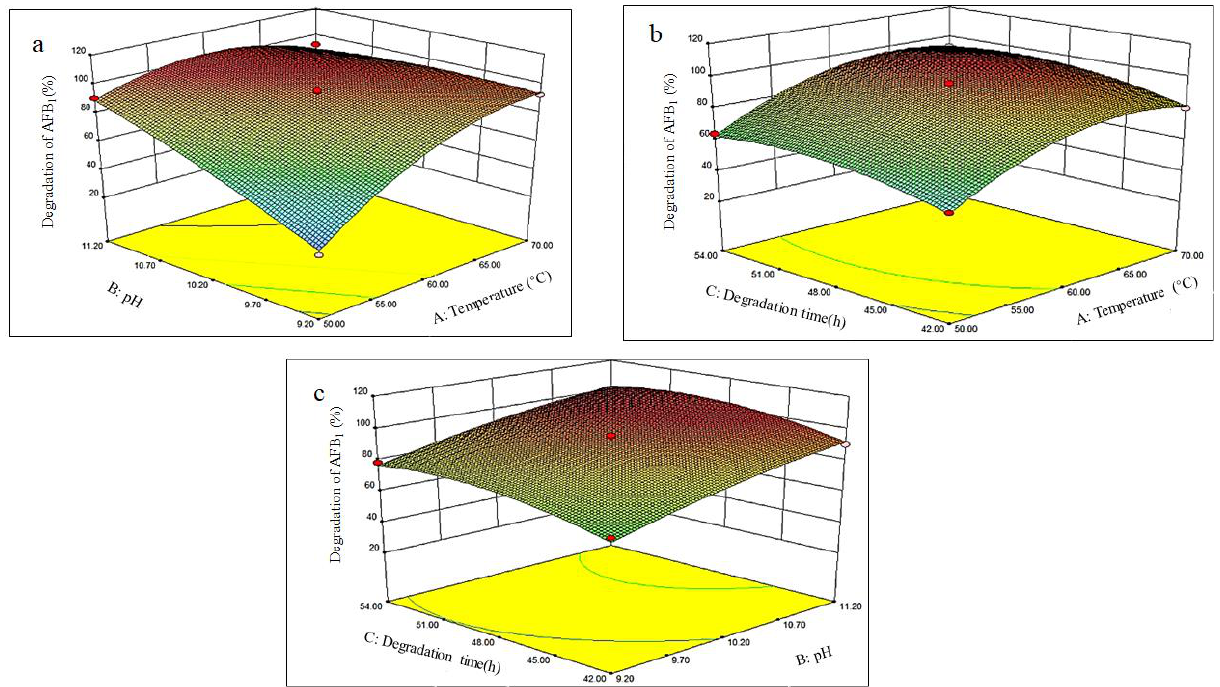
Figure 4. Response surface plots showing the interactive effects of various factors on the degrada- tion rate of AFB 1. Note: Figure ( a ) represents the effect of the interaction of the temperature and pH on the AFB 1 degradation rate; Figure ( b ) represents the effect of the interaction of the temperature and degradation time on the AFB 1 degradation rate; and Figure ( c ) represents the effect of the inter- action of the degradation time and pH on the AFB 1 degradation rate. Colors ranging from blue to red indicates low to high degradation rates. The lines in the y-coordinate have no real mean- ing.